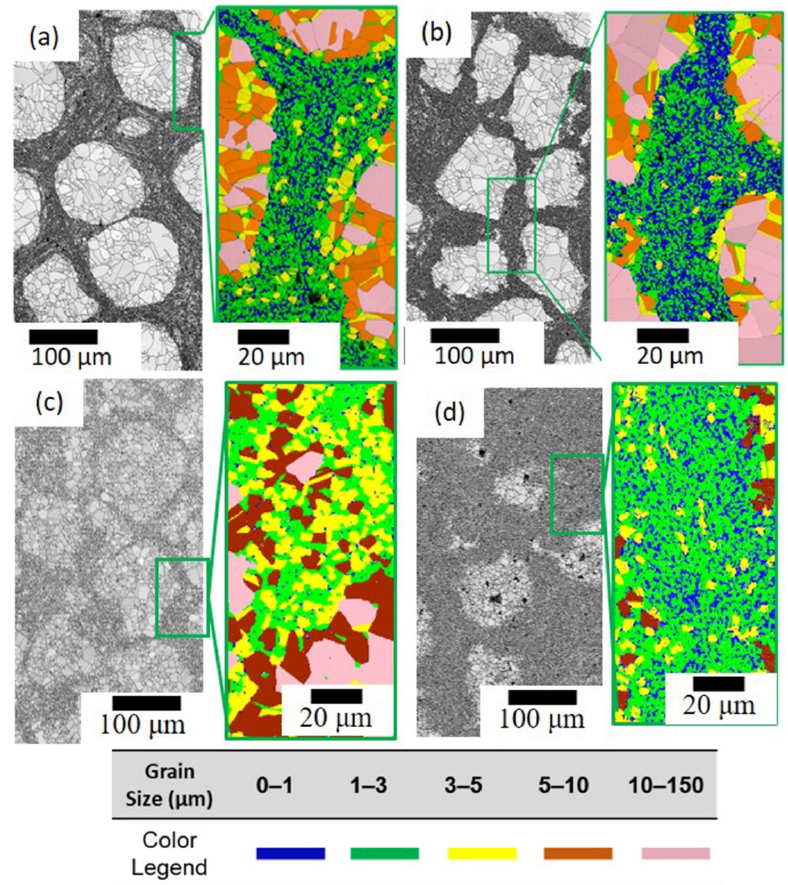
Figure 6. EBSD image quality maps of BiM ( a , b ), and MM compacts ( c , d ) of SUS316L. ( a ) BiM 36 ks, ( b ) BiM 180 ks, ( c ) MM 216 ks, and ( d ) MM 540 ks. The corresponding enlarged grain size images of the shell–core interface are separately shown (the grain size legend is presented at the